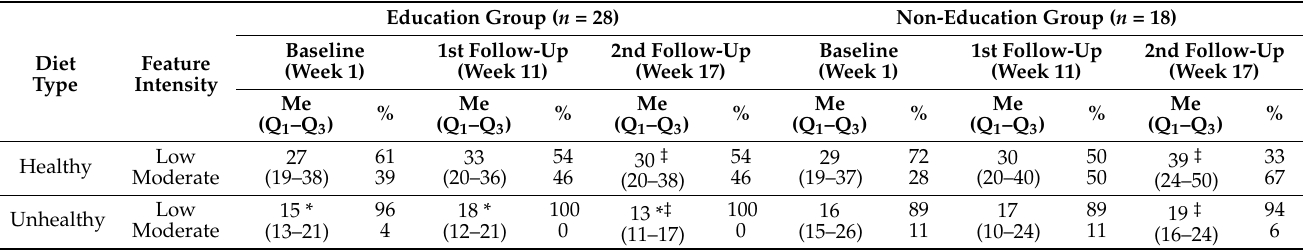
Table 3. Changes in the intensity of healthy and unhealthy diet patterns during the study follow- up